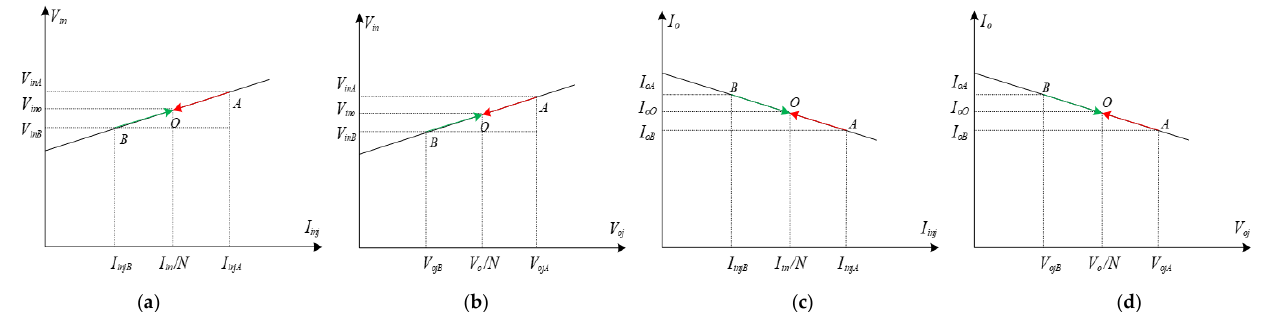
Figure 8. Voltage current relationship of distributed equalization control strategy: ( a ) Relationship between input voltage in- struction and input current; ( b ) Relationship between input voltage instruction and output voltage; ( c ) Relationship between output current instruction and input current; ( d ) Relationship between output current instruction and output voltage.